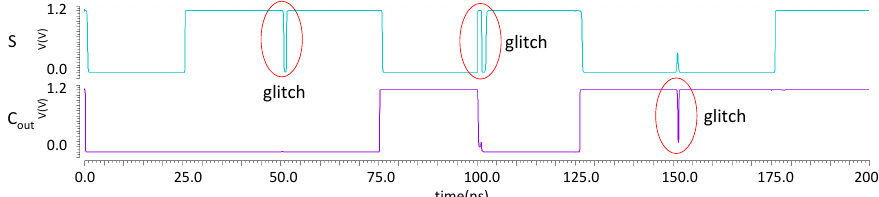
Figure 14. Appearance of glitches when slowing down the switching speed of the memristor. The parameters in Table 2 are adopted except for K on = − 0.01 m/s and K of f = 0.01